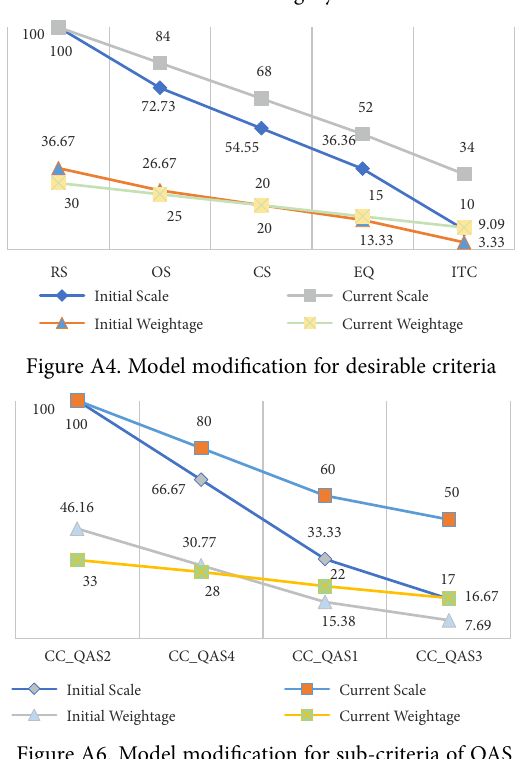
Figure A1. Model modification for categories Figure A2. Model modification for criteria of critical